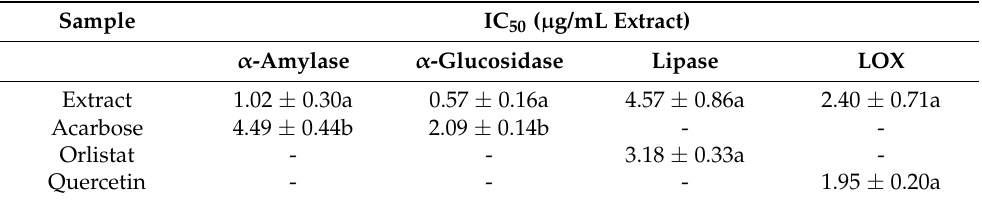
Table 4. The enzyme inhibition capacity (IC 50 values; µ g/mL) of red onion skins extract in α -amylase, α -glucosidase, lipase, and LOX enzymes. Sample IC 50 ( µ g/mL Extract) α -Amylase α -Glucosidase Lipase LOX Extract 1.02 ±